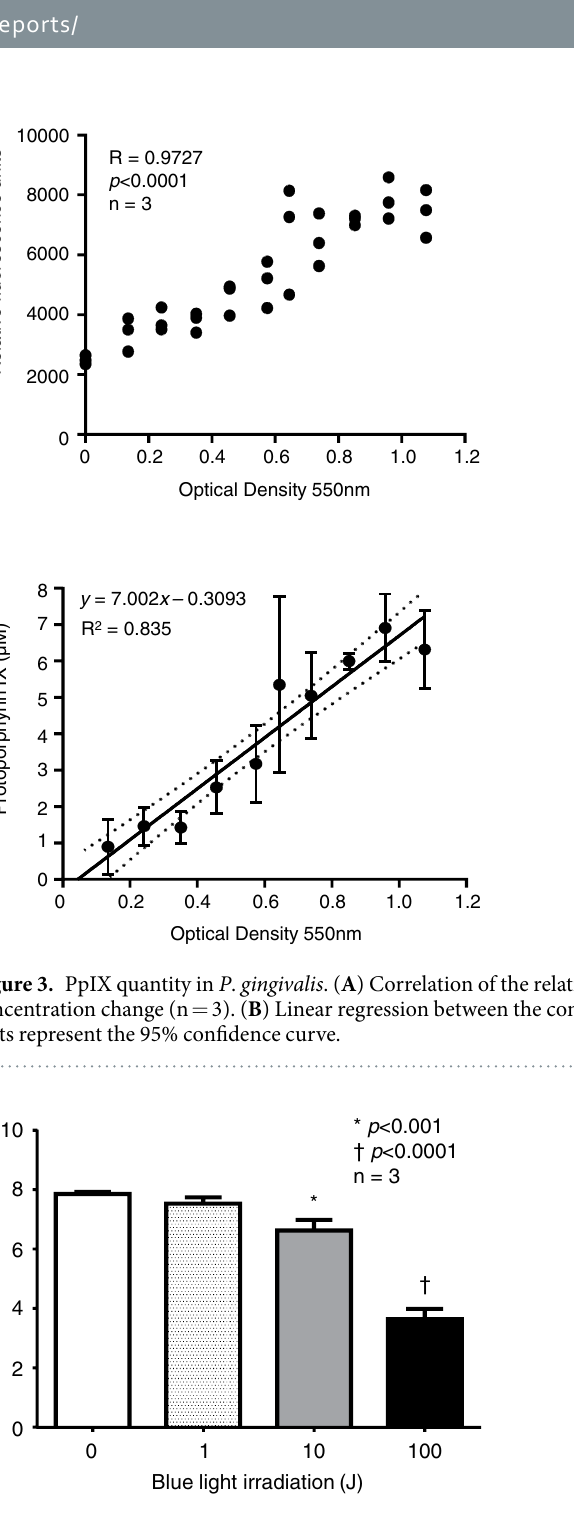
Figure 4. Effect of blue light irradiation on the viability of P . gingivalis . The data are expressed as means ± SD (n = 3). Significant differences are expressed with * for p < 0.001 and as † for p <